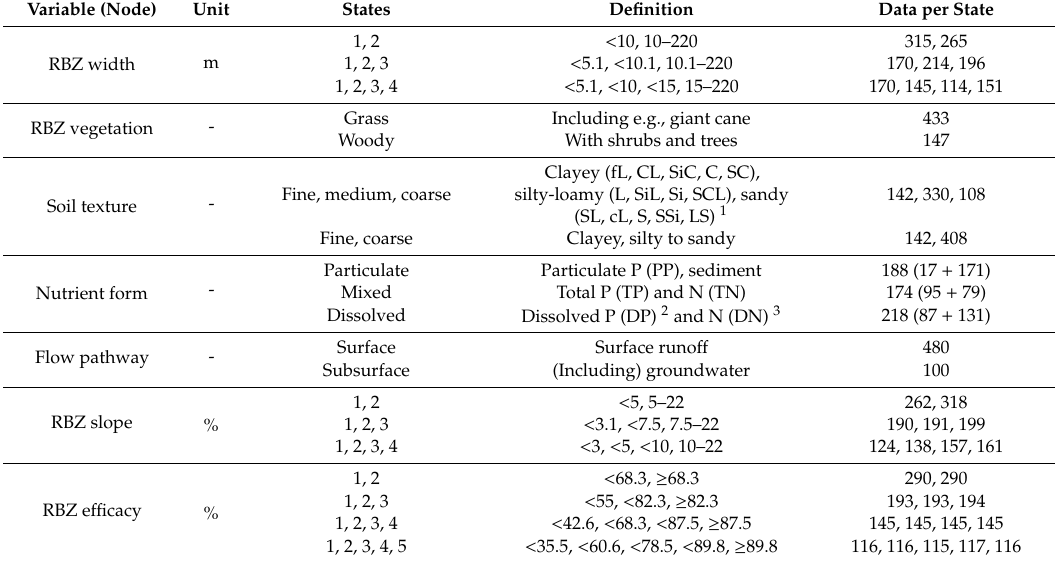
Table 1. List of riparian bu ff er zones (RBZ) and external variables used as nodes in the Bayesian networks (BN) and their discrete states. State definitions are shown as comma-separated lists. The variables (nodes) RBZ width, soil texture, RBZ slope, and RBZ e ffi cacy were discretized using di ff erent numbers of states (given in separate lines, cf. section on BN design for details on the state